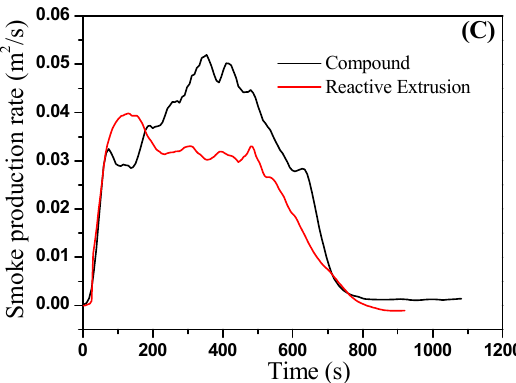
Figure 7. The heat release rate ( A ); Total heat release ( B ); and smoke production rate ( C ) of reactive extruded and compound EPDM/PP/IFR composites with 25% content of IFR.